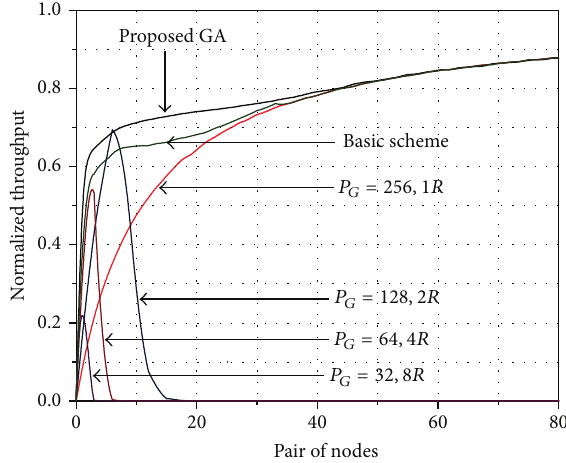
Figure 2: Throughput of the CSMA-CDMA protocol considering perfect power